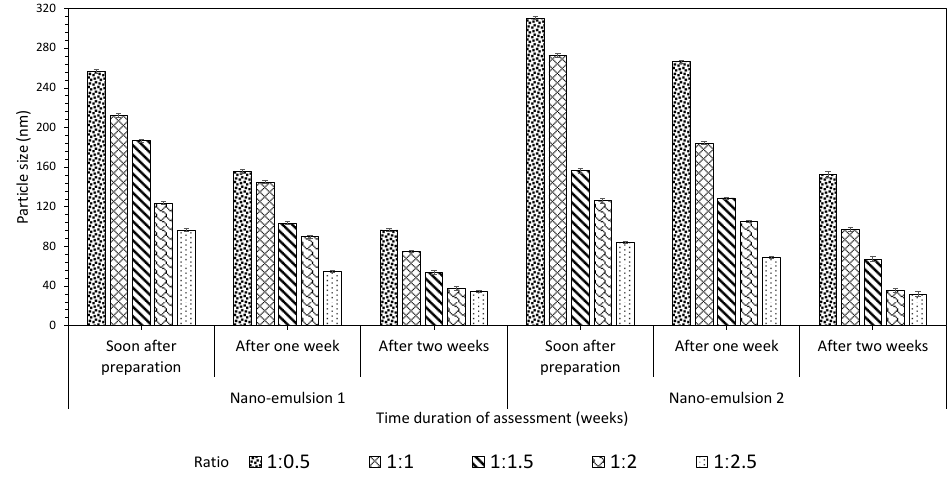
Figure 3. Particle size assessments.